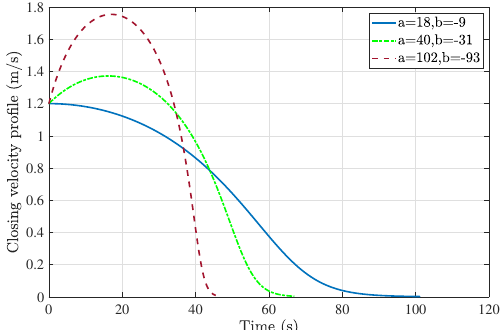
Figure 3. Effect of variation of ( a , b ) on closing velocity profile for moving target landing; V u 0 = 2 m/s, V t = 1 m/s and n =